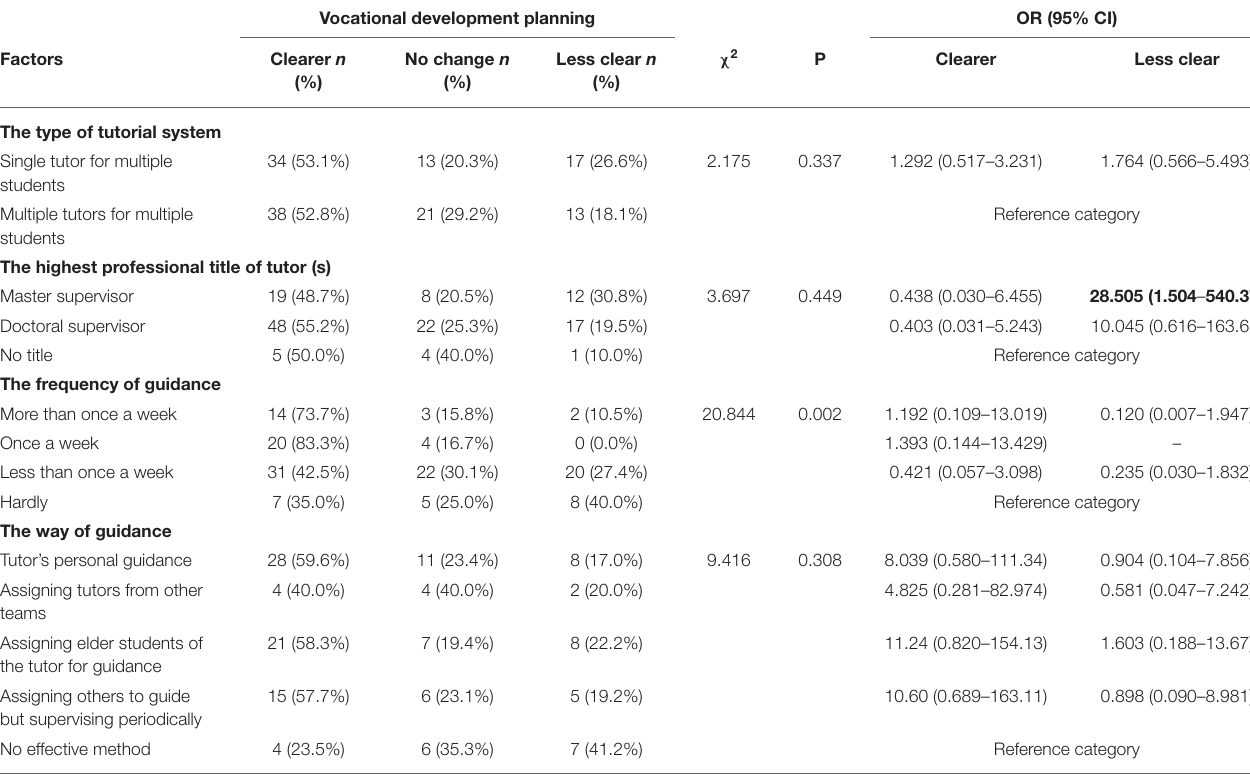
TABLE 5 | Multinomial logistic regression analysis of influential factors of vocational development planning after the guidance of the